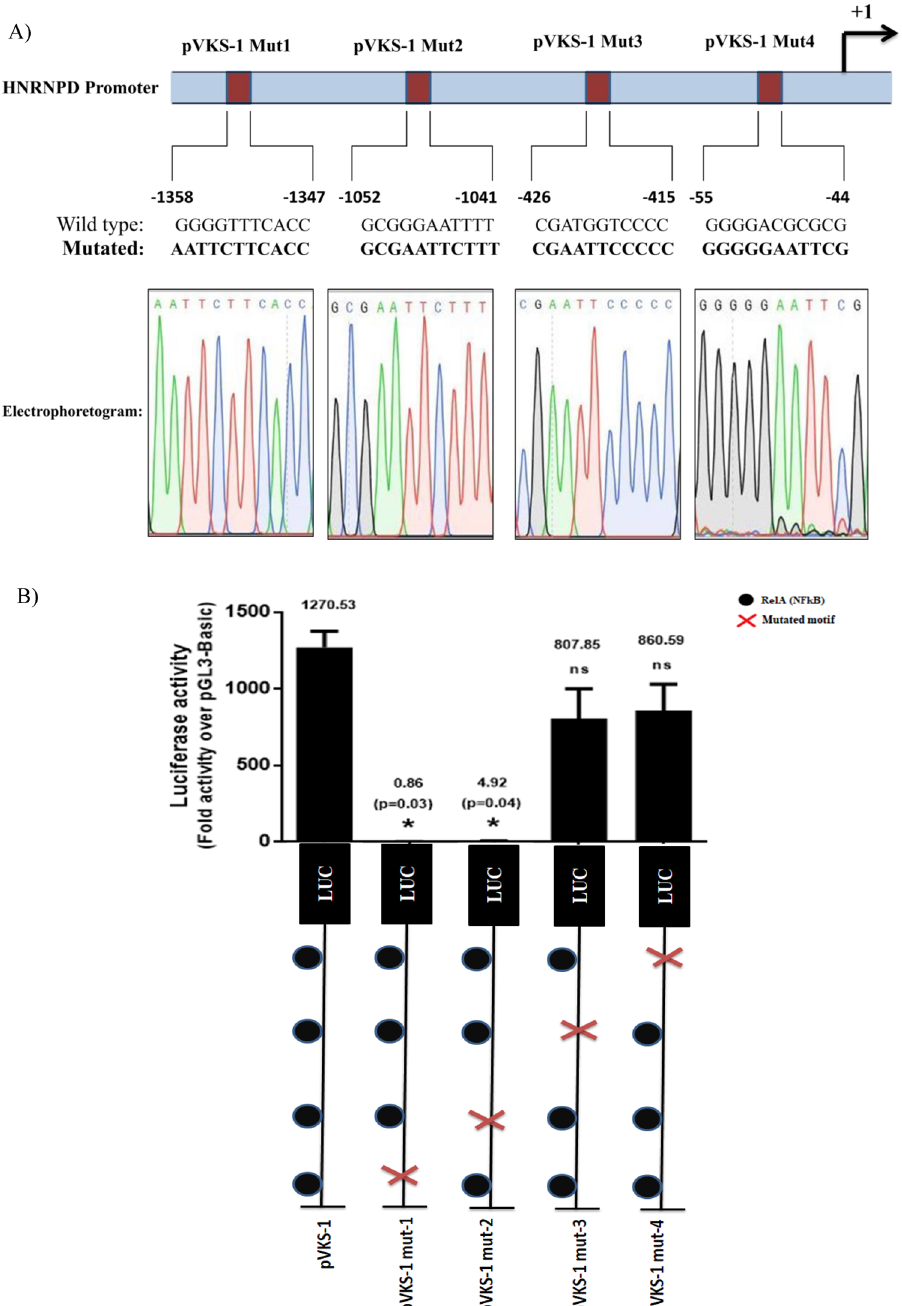
Figure 4. Functional relevance of NFκB binding motifs in human hnRNPD promoter. ( A ) Location and nucleotide sequence of the four putative NFκB (RelA) binding motifs as identified by in silico analysis of hnRNPD promoter. Each binding motif was individually subjected to site directed mutagenesis in promoter reporter construct pVKS-1 and the resulting constructs were named as pVKS-1 Mut1, pVKS-1 Mut2, pVKS-1 Mut3 and pVKS-1 Mut4 respectively. Mutation in each motif was confirmed by double stranded DNA sequencing and the mutated motifs have been shown in bold face along with their electrophoretogram. ( B ) Luciferase activity in SCC-4 cells after transfection with each mutant construct was assayed and compared with the activity of pVKS-1. Other details are given in Materials and Methods. Values are mean ± SD from four independent experiments performed in triplicate. Results were analyzed using a paired two tailed Student’s t-test and values significantly different from pVKS-1 marked by (*P ≤